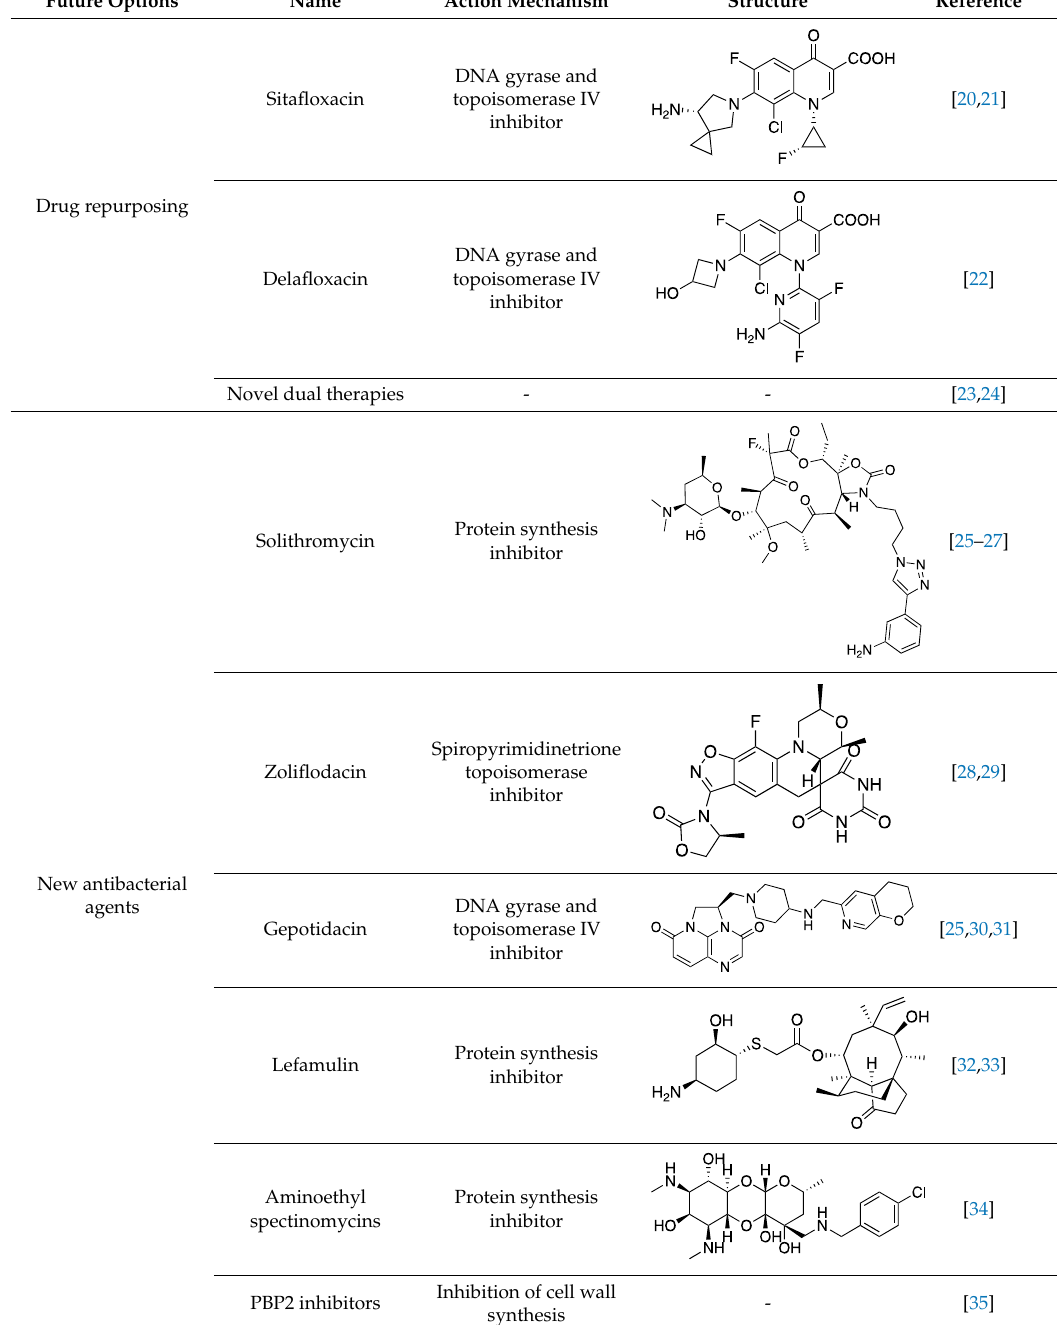
Table 2. Antigonococcal agents currently under development.